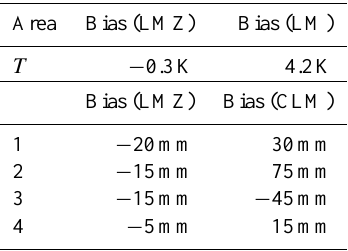
Table 1. Temperature and precipitation biases of LMZ and (C)LM for selected